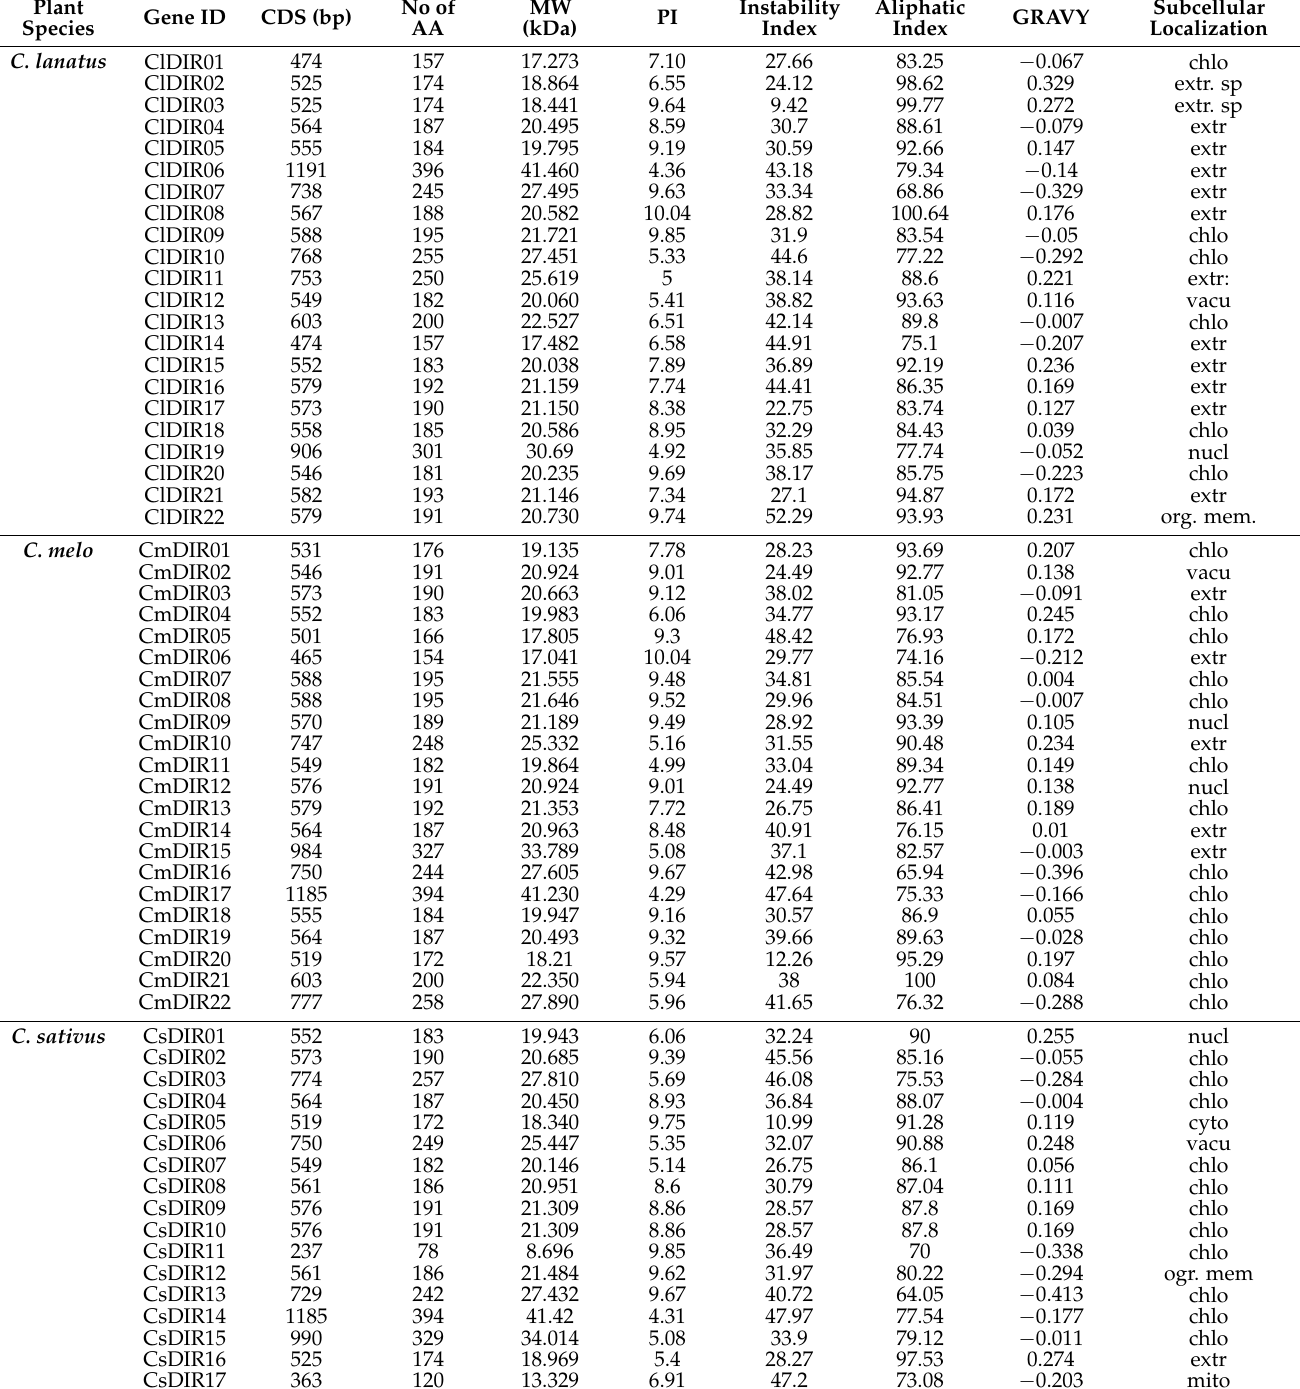
genes of different plant species [3,39]. Table 1. List of identified dirigent proteins in major cucurbits, sequence characteristics and protein properties. MW— molecular weight; pI—isoelectric point; chlo—chloroplast; extr—extracellular space; mito— mitochondria; vacu—vacoule;